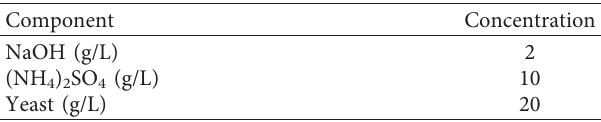
Table 2: Liquid medium